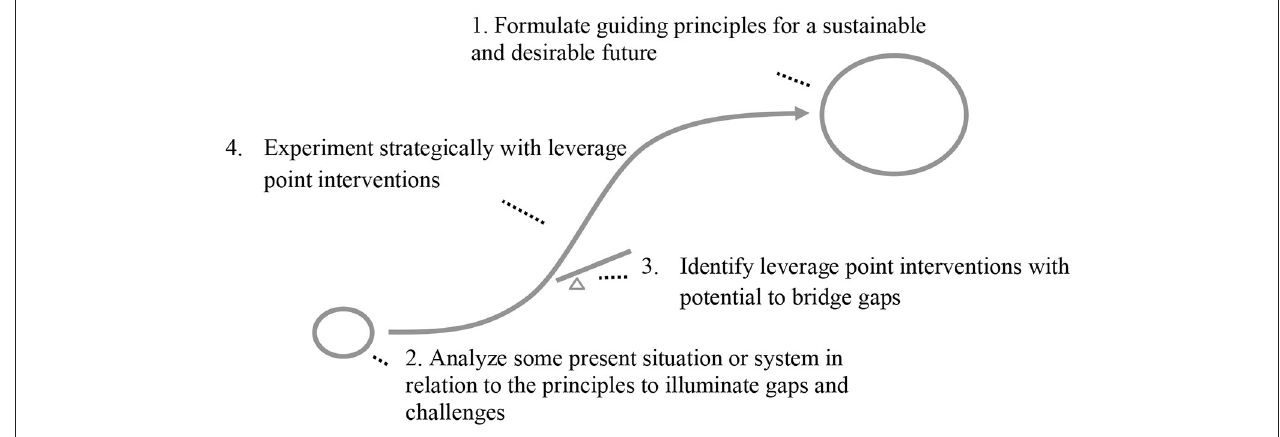
FIGURE 1 | Primary steps in a backcasting from principles methodology [adapted from Holmberg (1998) and Holmberg and Larsson